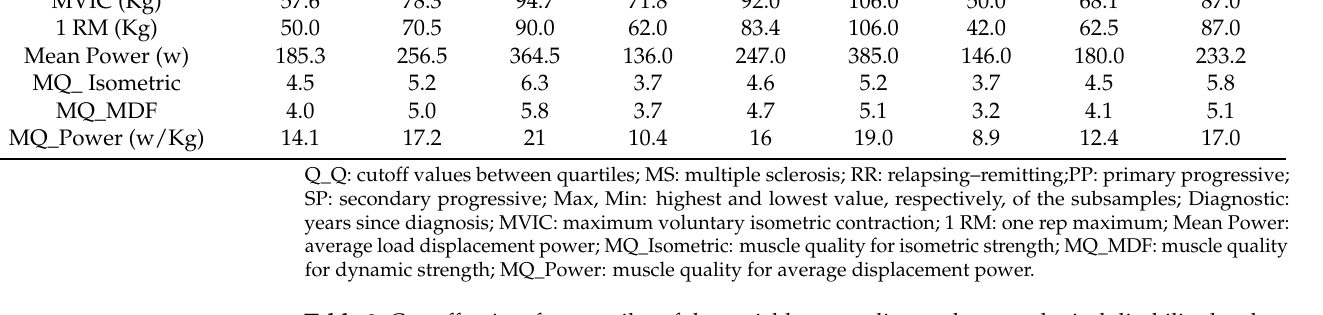
Table 8. Cut-off points for quartiles of the variables according to the neurological disability level. EDSS